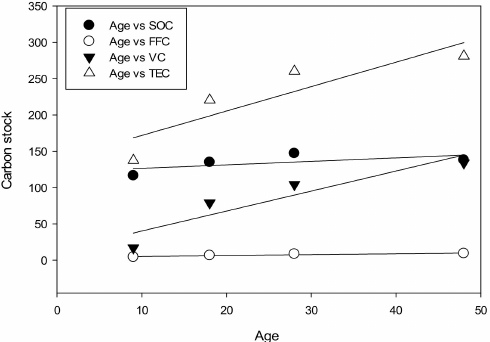
Figure 5. Relationship of age (year) and soil organic carbon (Mg ha − 1 ), forest floor carbon (Mg ha − 1 ), vegetationcarbon(Mgha − 1 )andtotalecosystemcarbon(Mgha − 1 ), inMassonpine( P.massoniana